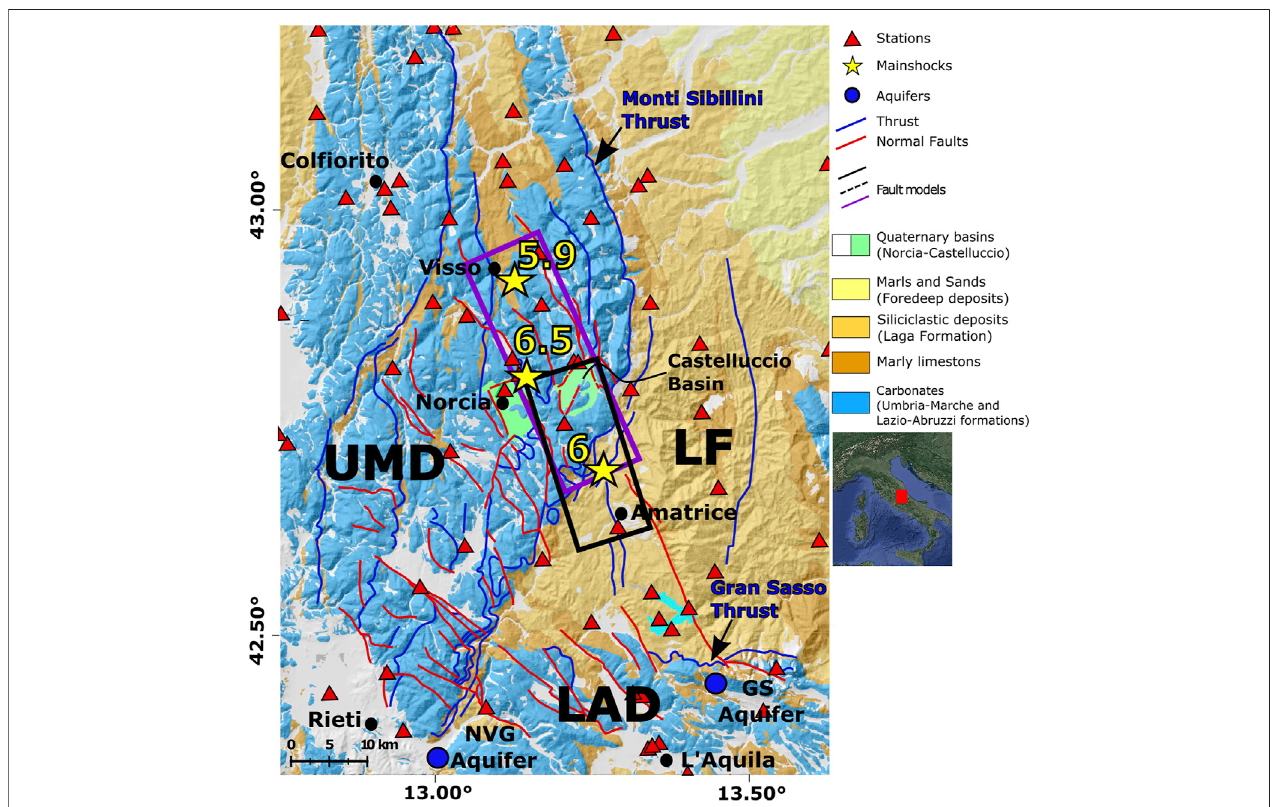
FIGURE1| Simpli fi edgeologicalmapofCentralItaly(afterDiBuccietal.,2021).Blue:carbonatesoftheUmbria – Marche(UMD)andLazio – Abruzzi(LAD)domains; yellow: foredeep domain (LF, Laga Formation). The seismic network used for the sequence period is represented with red triangles. Yellow stars correspond to the Amatrice (M w 6), Visso (M w 5.9), and Norcia (M w 6.5) mainshocks. The black and purple boxes are the Mt. Gorzano (Amatrice) and Mt. Vettore (Norcia) fault planes, respectively. Blue circles are the Nuria – Velino – Giano (NVG) and Gran Sasso (GS) aquifers. The study area within the Italian Peninsula framework is shown in the inset on the right